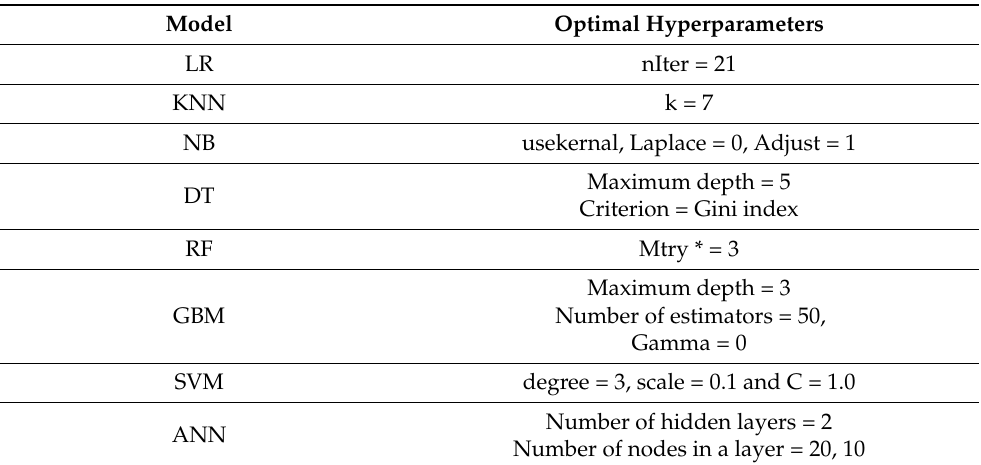
LR, logistic regression; KNN, k-nearest neighbors; NB, naïve Bayes; DT, decision tree; RF, random forest; GBM, gradient boosting machine; SVM, support vector machine; ANN, artificial neural networks. * mtry indicates the number of variables available for splitting at each tree